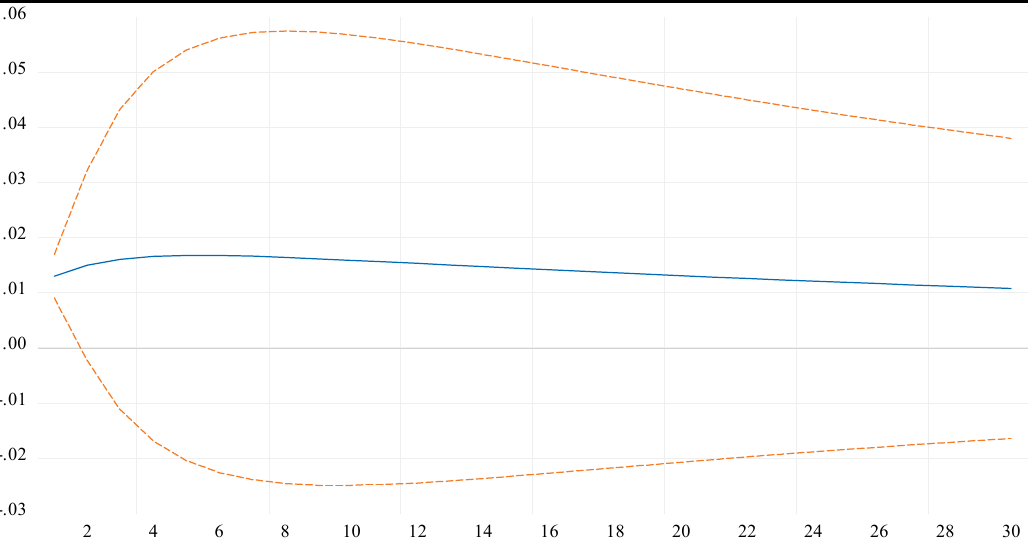
Figure 10. LCO 2 forecast error variance decomposition results.